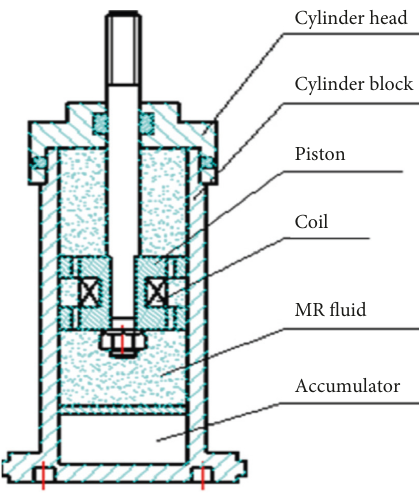
Figure 1: Structure of the MR